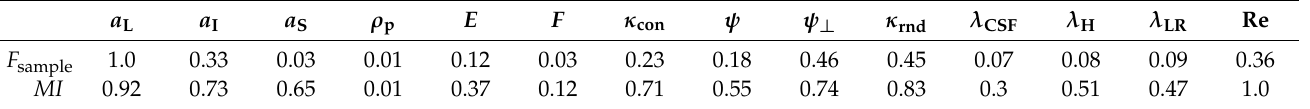
Table 3. Normalized results of a F-test and the mutual information for feature selection regarding the drag coefficient. a L